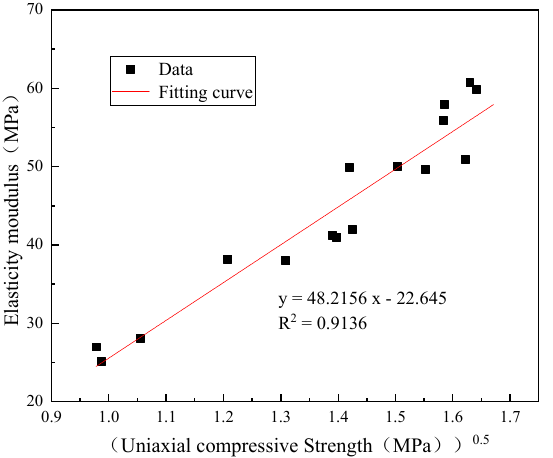
Figure 20. Regression analysis between elastic modulus and square root of uniaxial compressive strength. The results show that there was a significant linear relationship between elastic modu- lus and uniaxial compressive strength, and the correlation coefficient was 0.986. The elastic modulus also had a good correlation with the square root of uniaxial compressive strength, with a correlation coefficient of